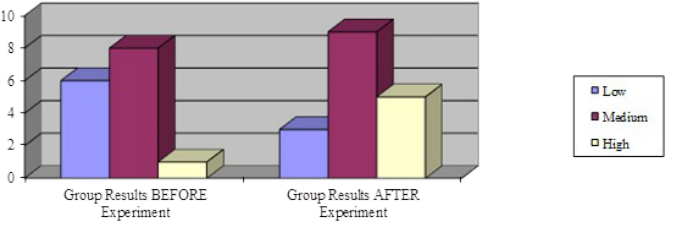
Figure 1 - Histogram of the Level of Formation of Monologue Speech before and after Experimental Research DOI: